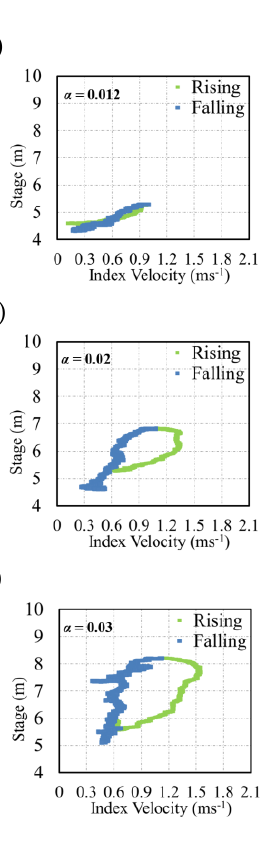
Figure 8. Sensitivity of the hysteresis severity to flow magnitude and rates of changes: ( a ) event #24 (2015); ( b ) event #60 (2018); ( c ) event #50 (2017). The stage and time scales in the plots are intentionally kept identical (i.e., one month) to better substantiate the comparison. Arrows in figures indicate approximate timing for index velocity, discharge, and stage hydrographs peaks.